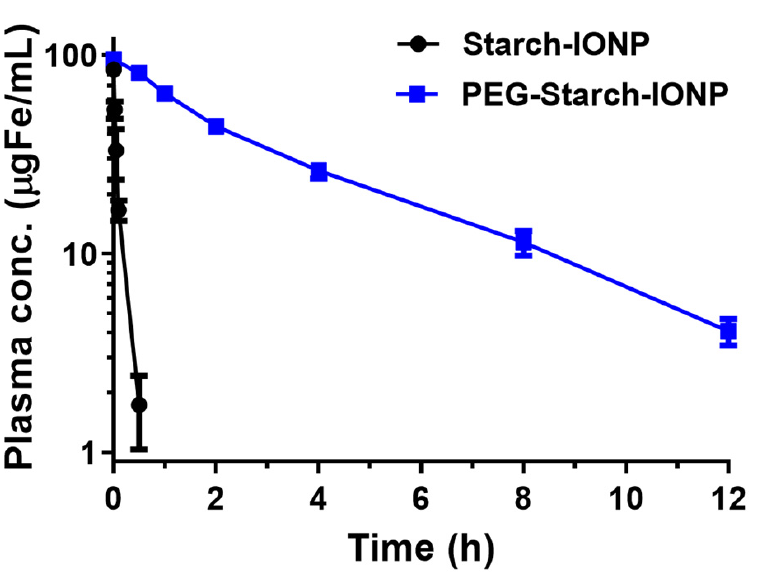
Figure 8. Plasma concentration-versus-time profiles of PEG–starch–IONPs in mice (N = 3). Com- pared with starch–IONPs, PEG–starch–IONPs exhibited a markedly longer residence in the plasma half-life: 5.8 min vs. 2.7 h for starch–IONPs and PEG–starch–IONPs, (plasma half-life: 5.8 min vs. 2.7 h for starch–IONPs and PEG–starch–IONPs, respectively).